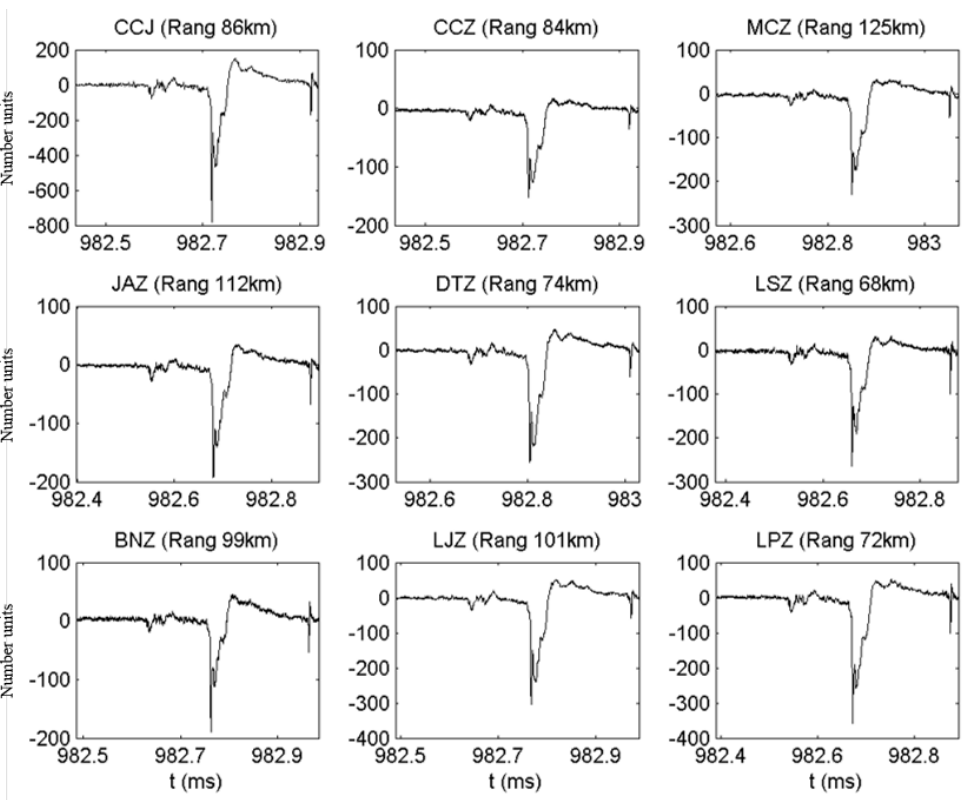
Figure 5. The recording length is set to 500 µ s with a pre-trigger of 150 µ s.